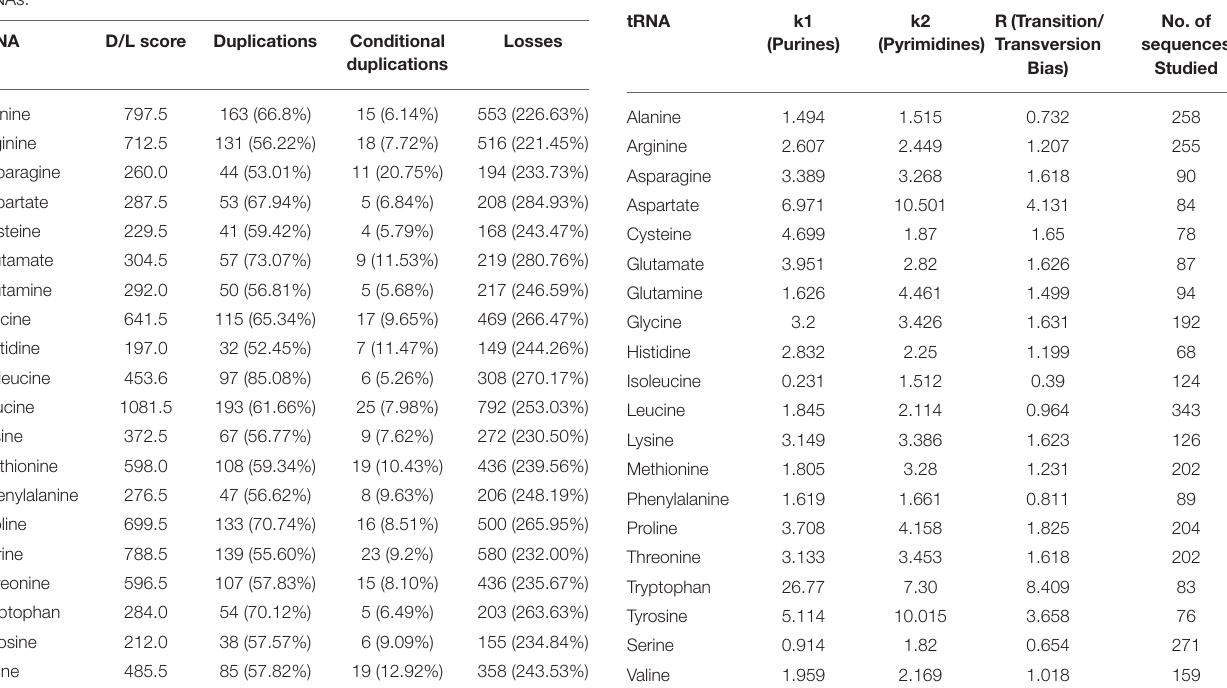
TABLE 6 | Transition/transversion bias of cyanobacterial